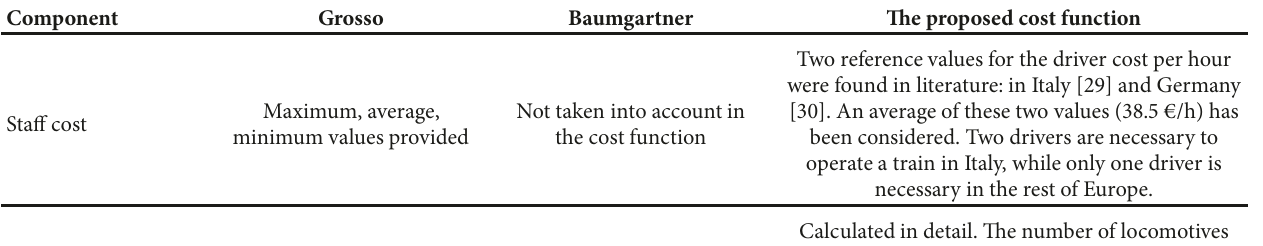
Table 3: Comparison of the proposed cost function with similar cost functions existing in literature: namely those proposed by Grosso [20] and Baumgartner